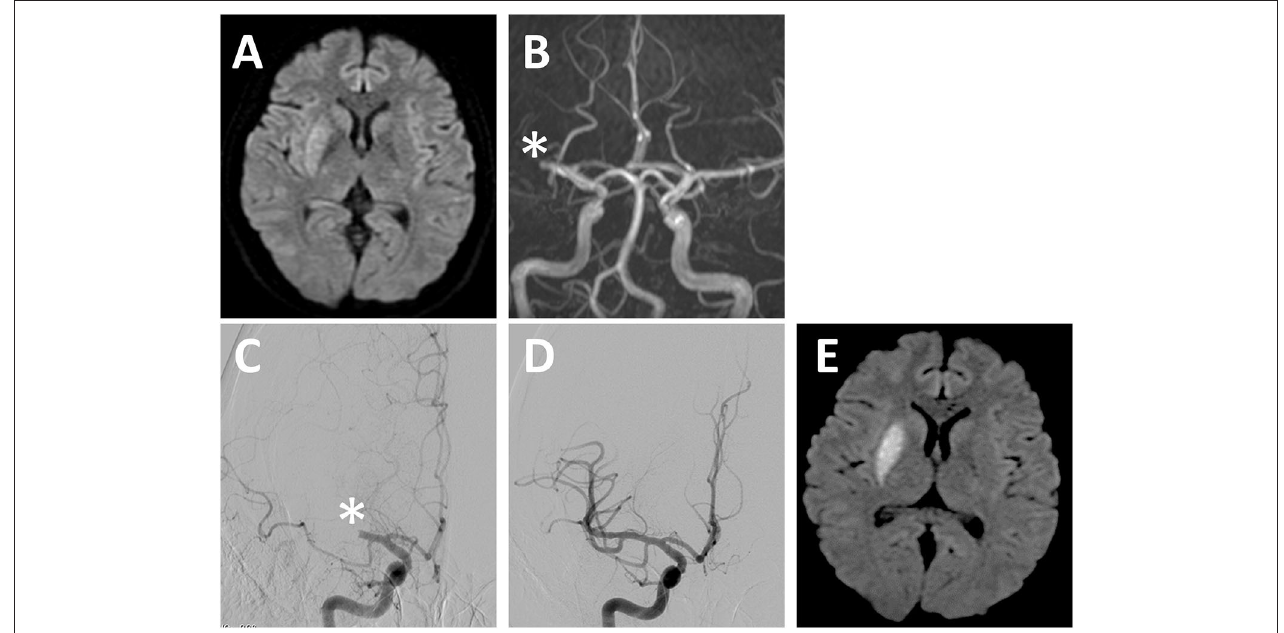
FIGURE 2 | Representative case. (A) DWI and (B) MR angiography image on admission. MR angiography images at (C) pretreatment and (D) posttreatment with EVT. DWI on the following day of EVT (E) . EVT, endovascular thrombectomy; DWI, diffusion-weighted imaging; MR, magnetic resonance. *Occluded